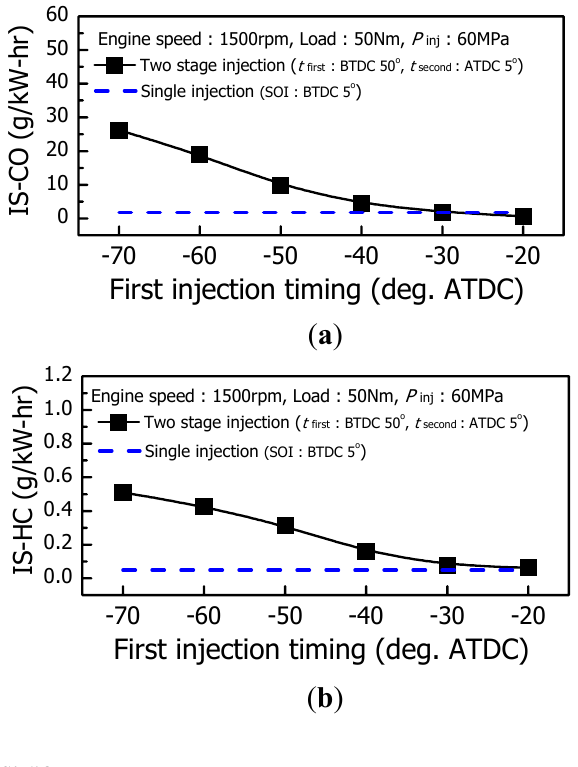
Figure 7. IS-CO and IS-HC emission characteristics according to first injection timing of two stage injection: ( a ) IS-CO; ( b ) IS-HC.